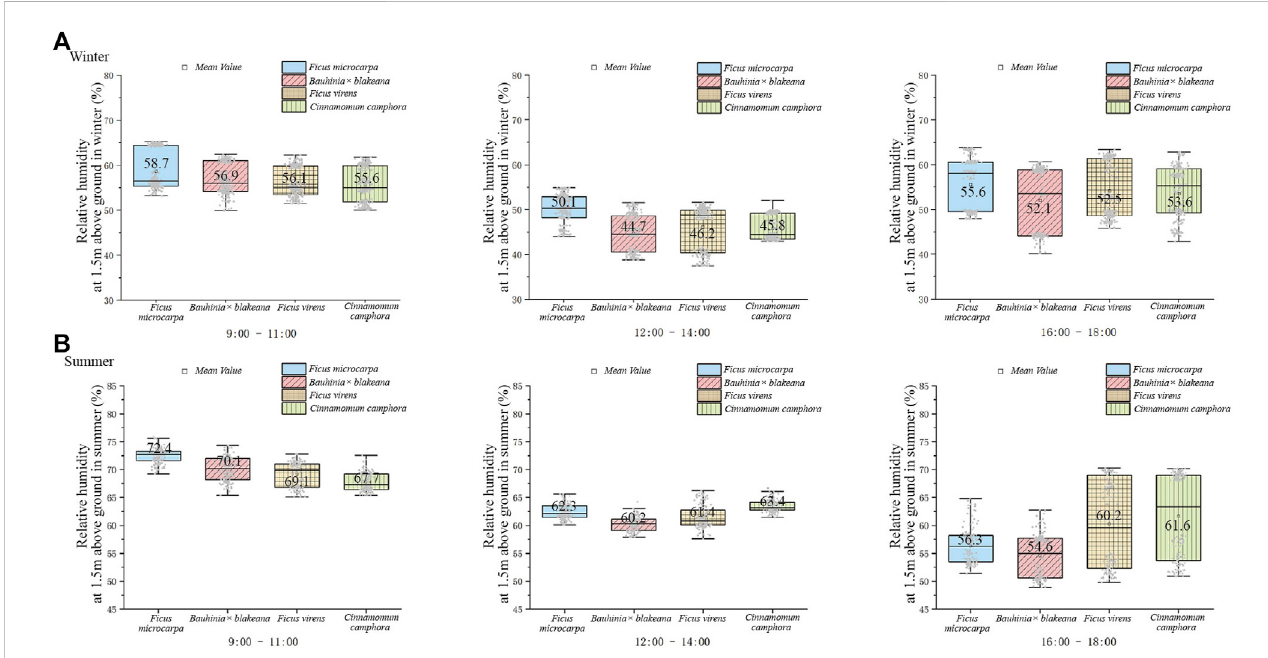
Relative humidity underneath the canopy of the four tree species in winter (A) and summer (B) .